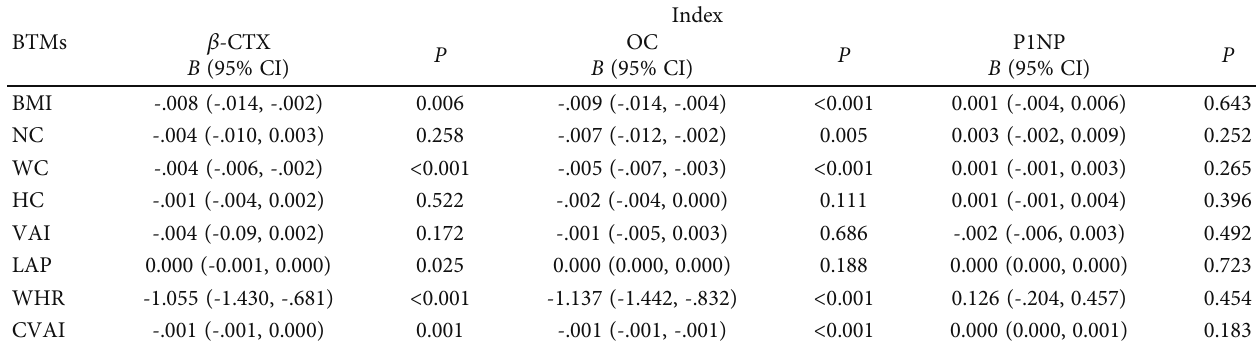
Table 2: Correlation of abdominal obesity index and